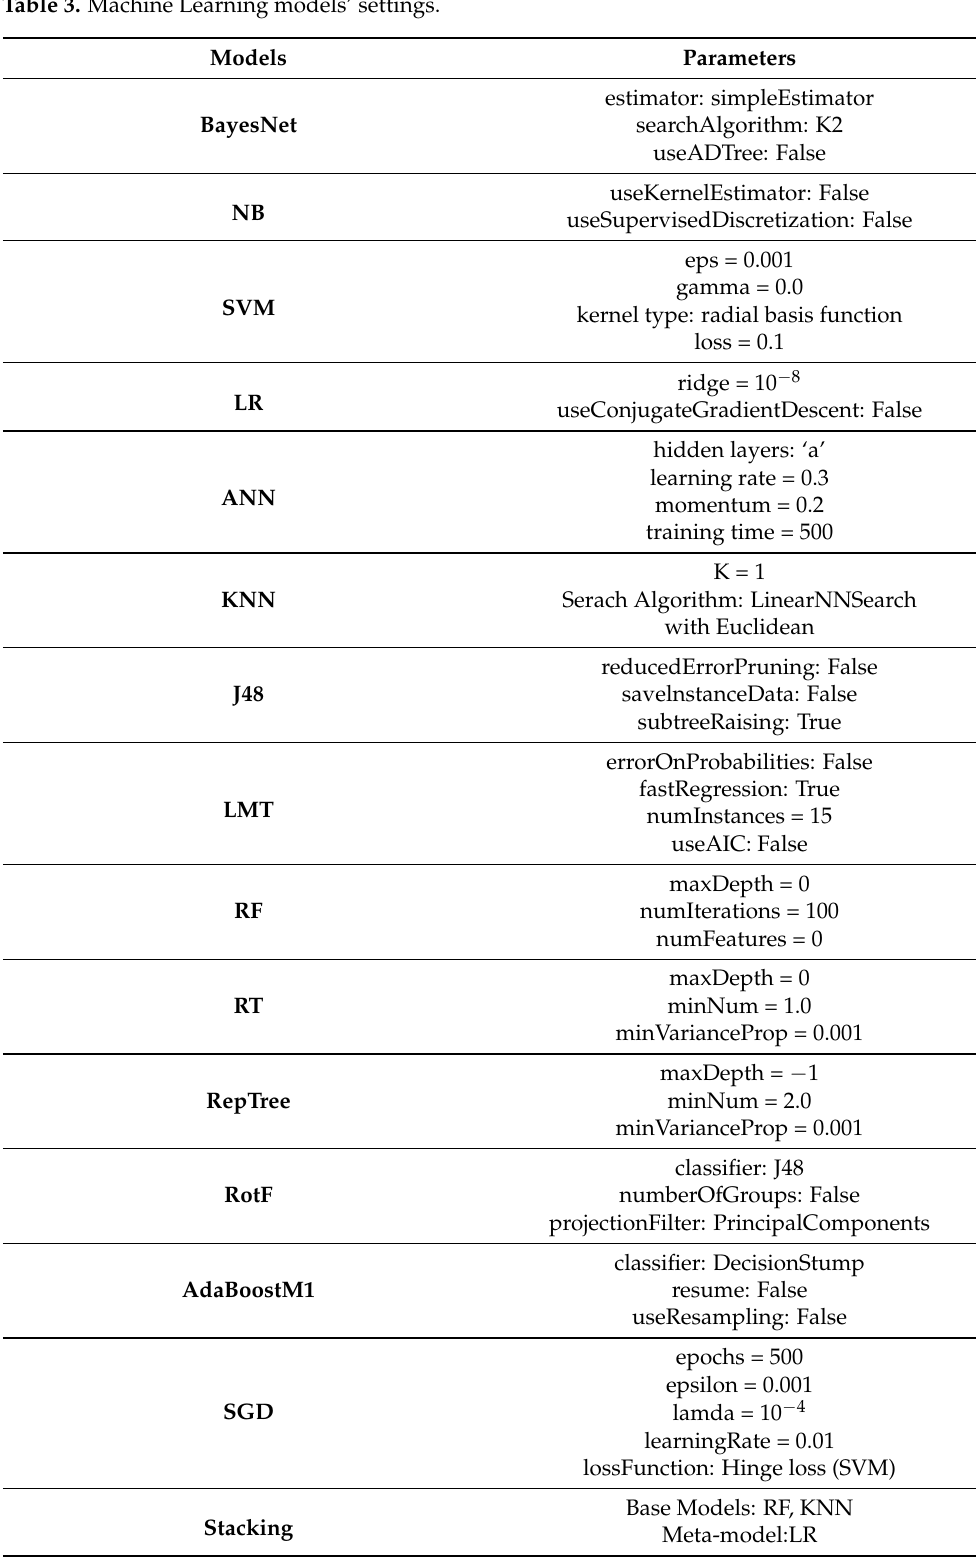
Table 3. Machine Learning models’